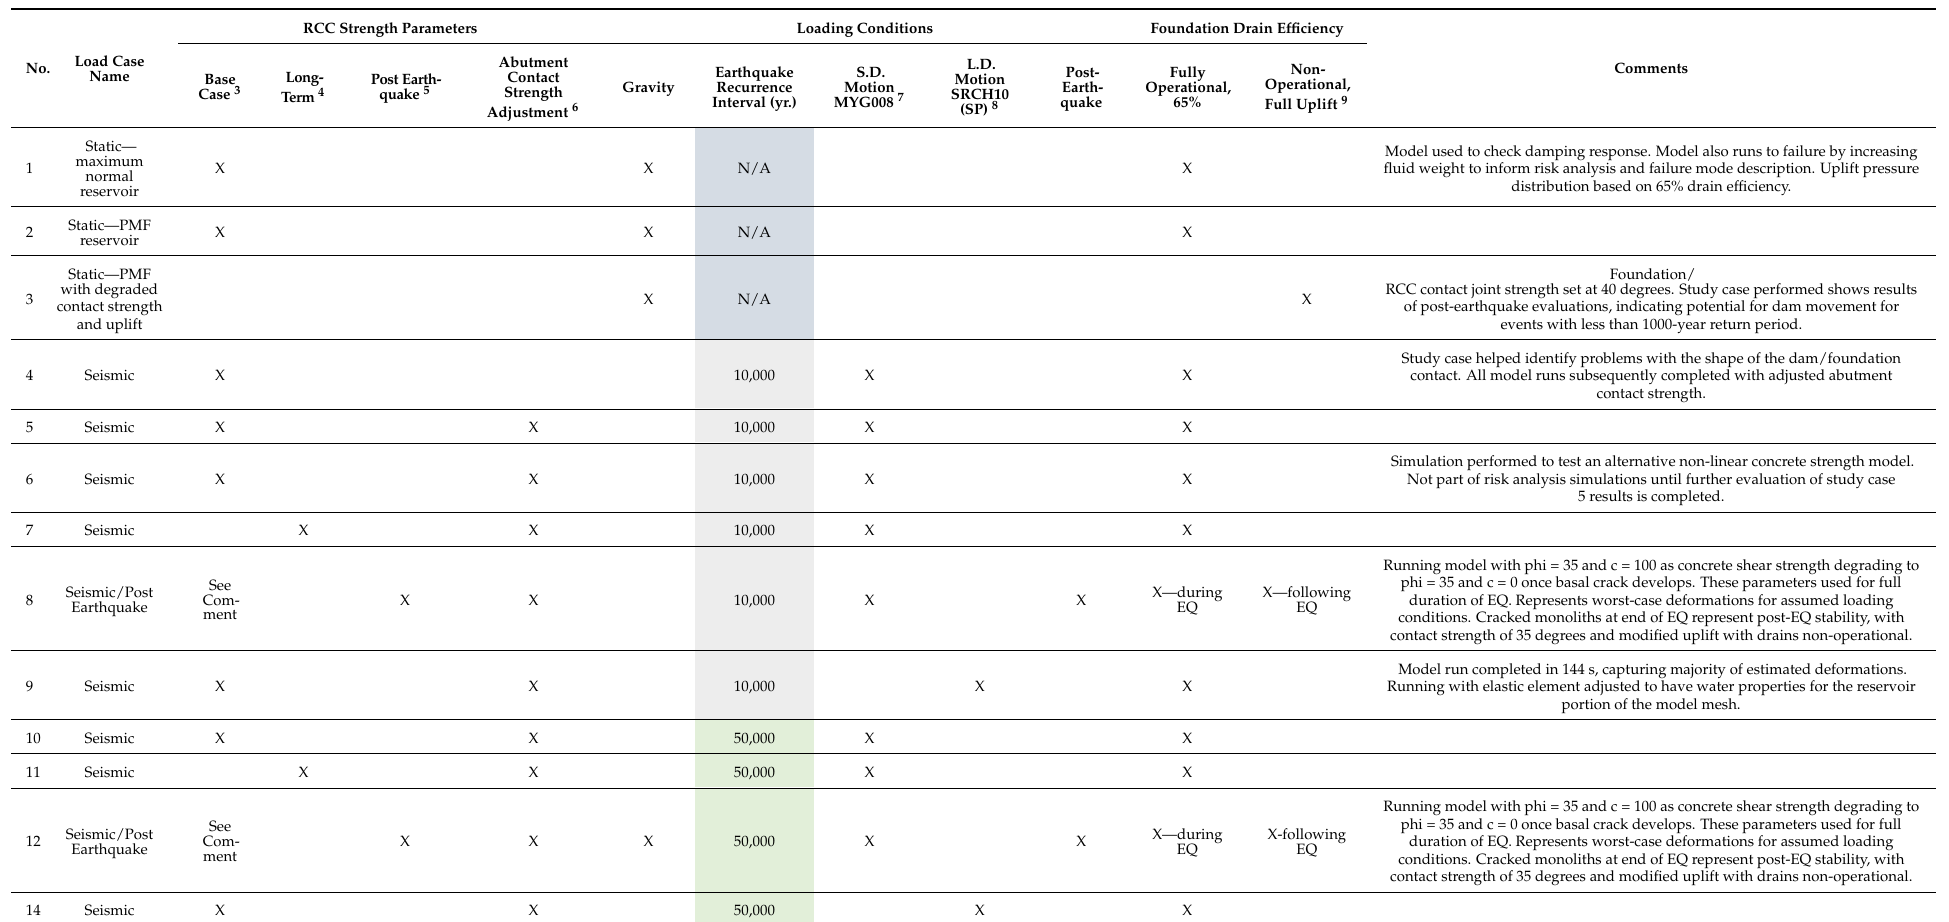
Table A1. Summary of study cases using 3D model to support risk